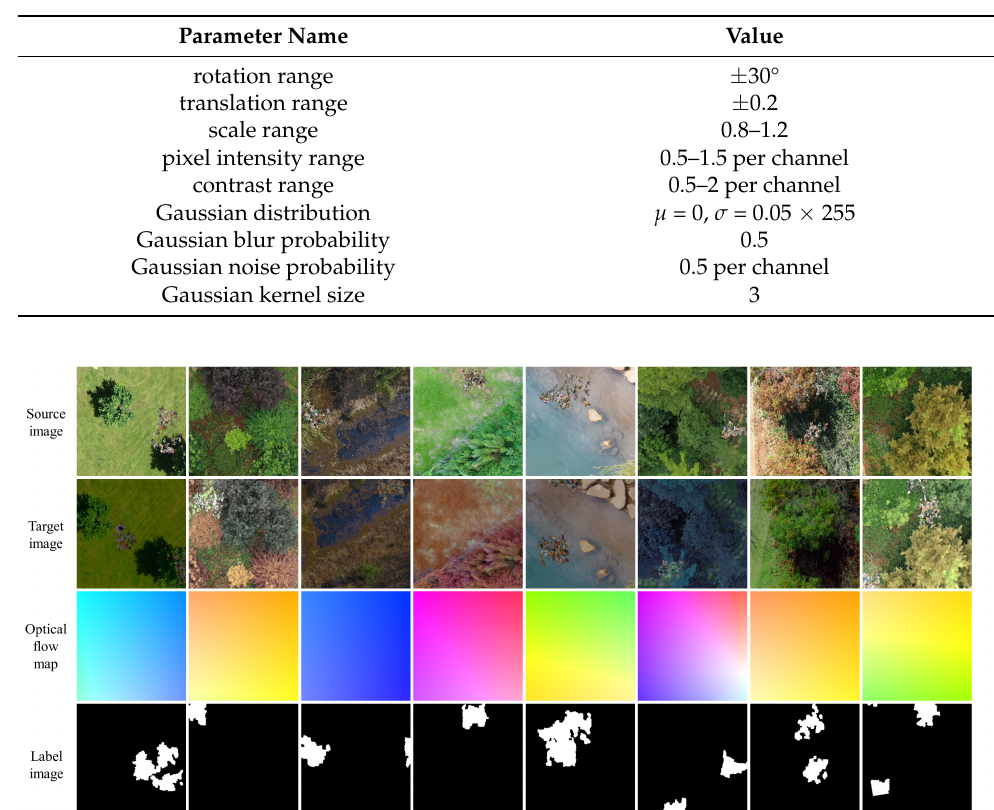
Figure 8. The overview of the dataset. Optical flow field color is encoded with the same method used in FlowNet